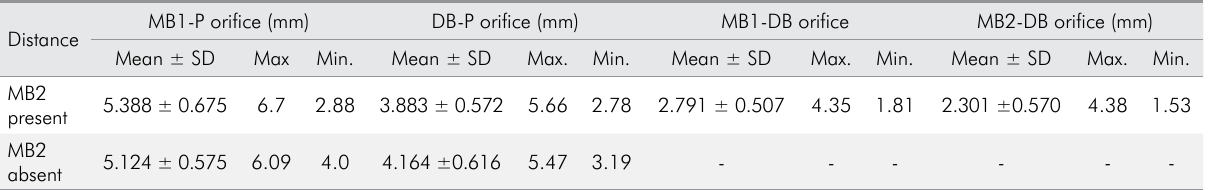
Table. Distances between root canal orifices in maxillary first molars.